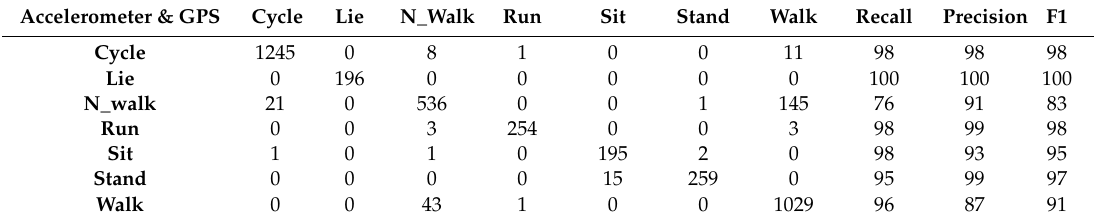
Table A4. Confusion matrix of a participant when using accelerometer and GPS data for knee position. (Scenario